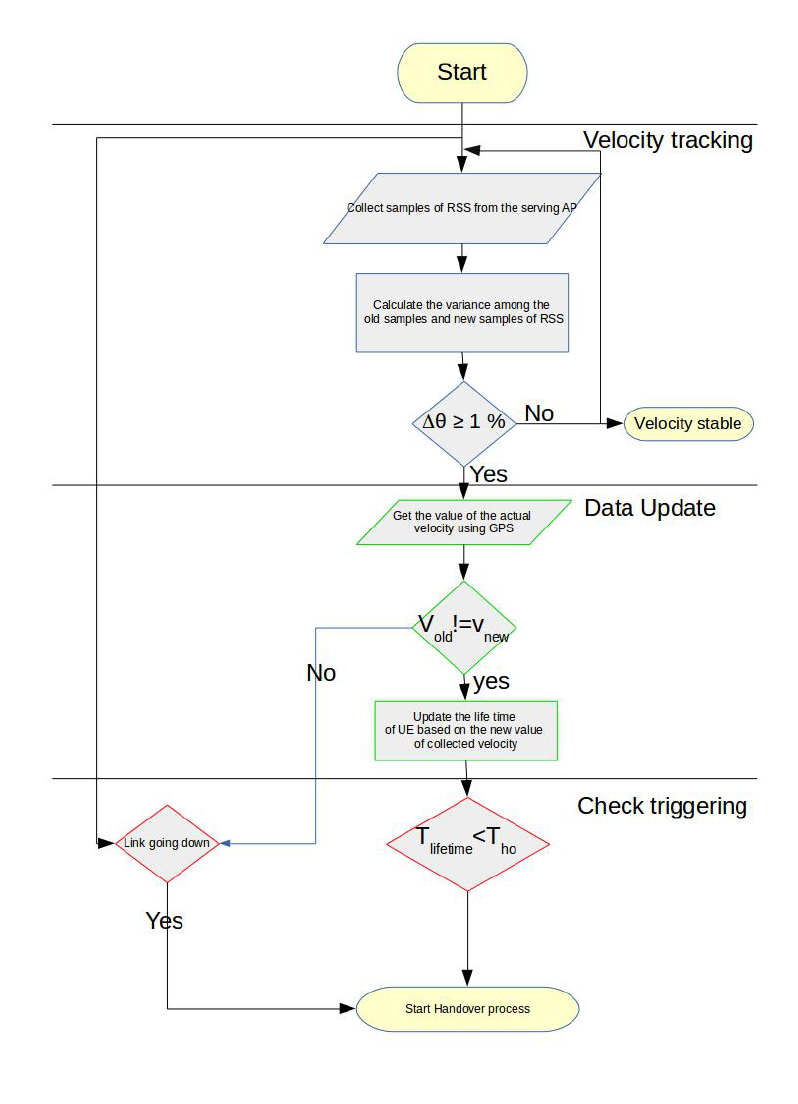
Figure 4. Flow chart for handover decision-based